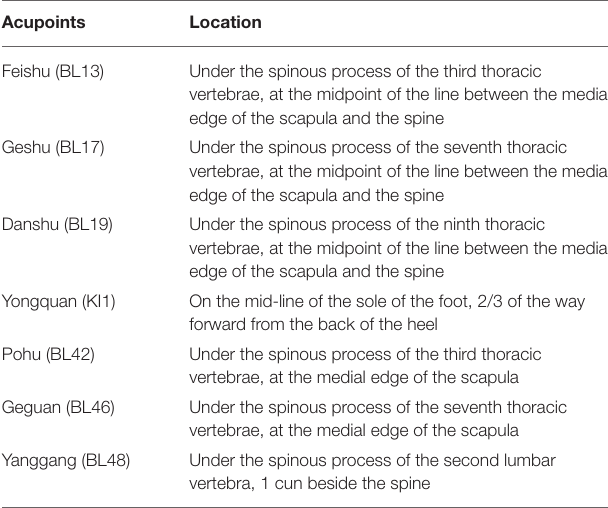
TABLE 2 | Specific acupuncture methods of each acupoint. TABLE 3 | The location of moxibustion